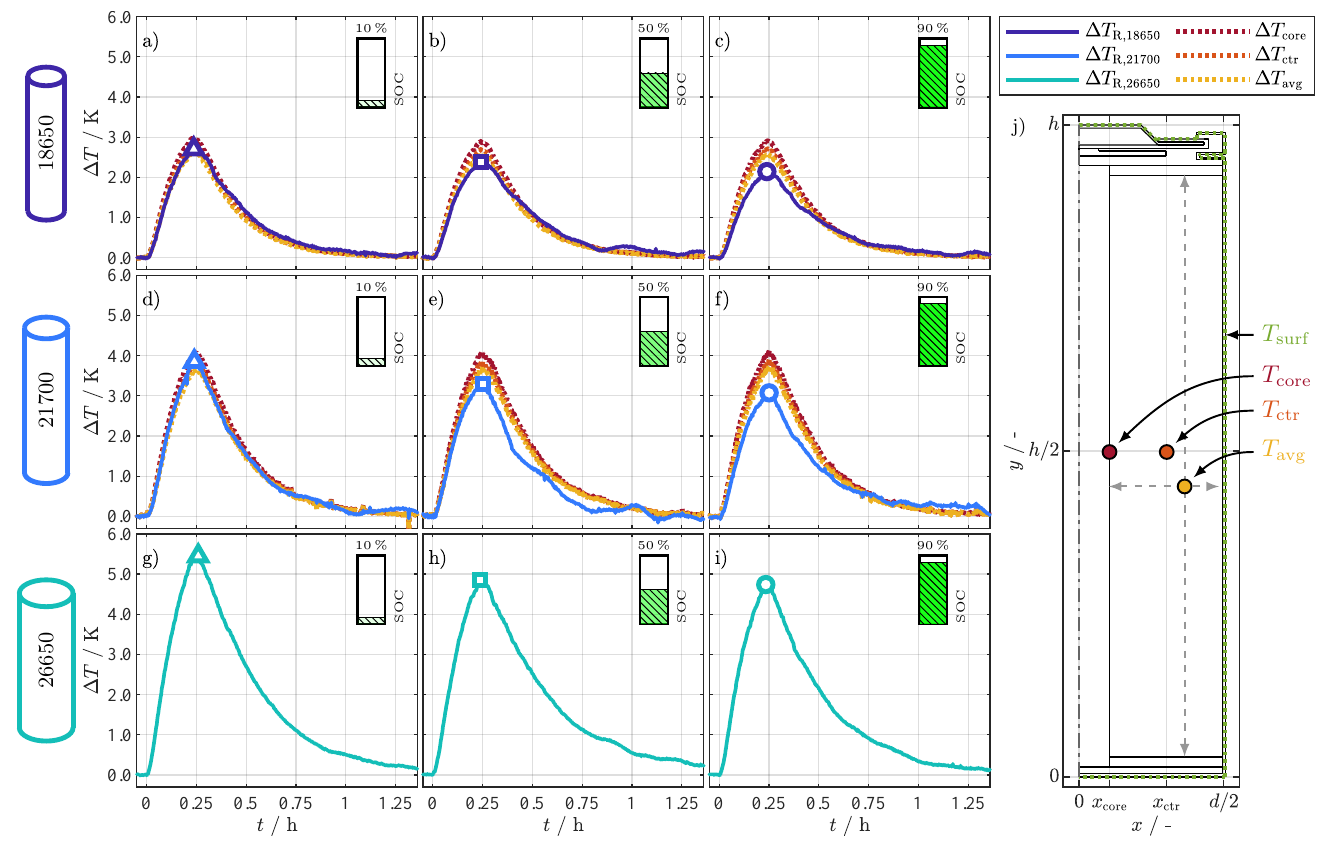
Figure 5. Temperature differences ∆ T averaged surface temperature ( T point and for each cell format. Additional temperature differences ∆ T core , ∆ T ctr , and ∆ T avg in ( a – f ) for the three simulated temperature locations of the jelly roll in ( j ) according to the 2D thermal model simulation results for the 18650 and 21700 format. The differences are again related to the averaged surface temperature. T core and T ( x core ), respectively at the center ( x ctr ) of the jelly roll. T avg represents the average simulated jelly roll